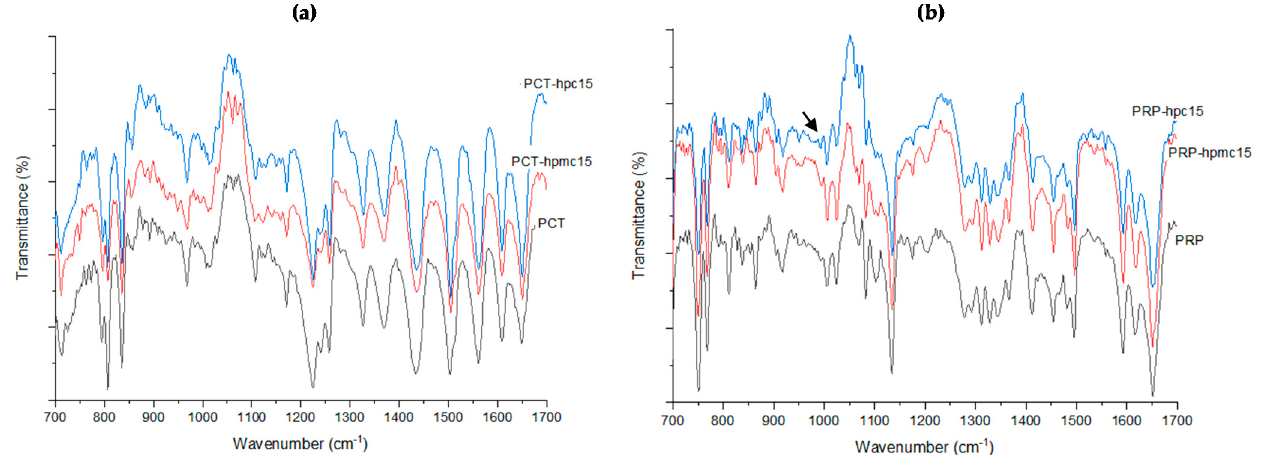
Figure 3. ATR–FTIR spectra of neat PCT ( a ) and neat PRP ( b ) and corresponding co-spray dried batches.